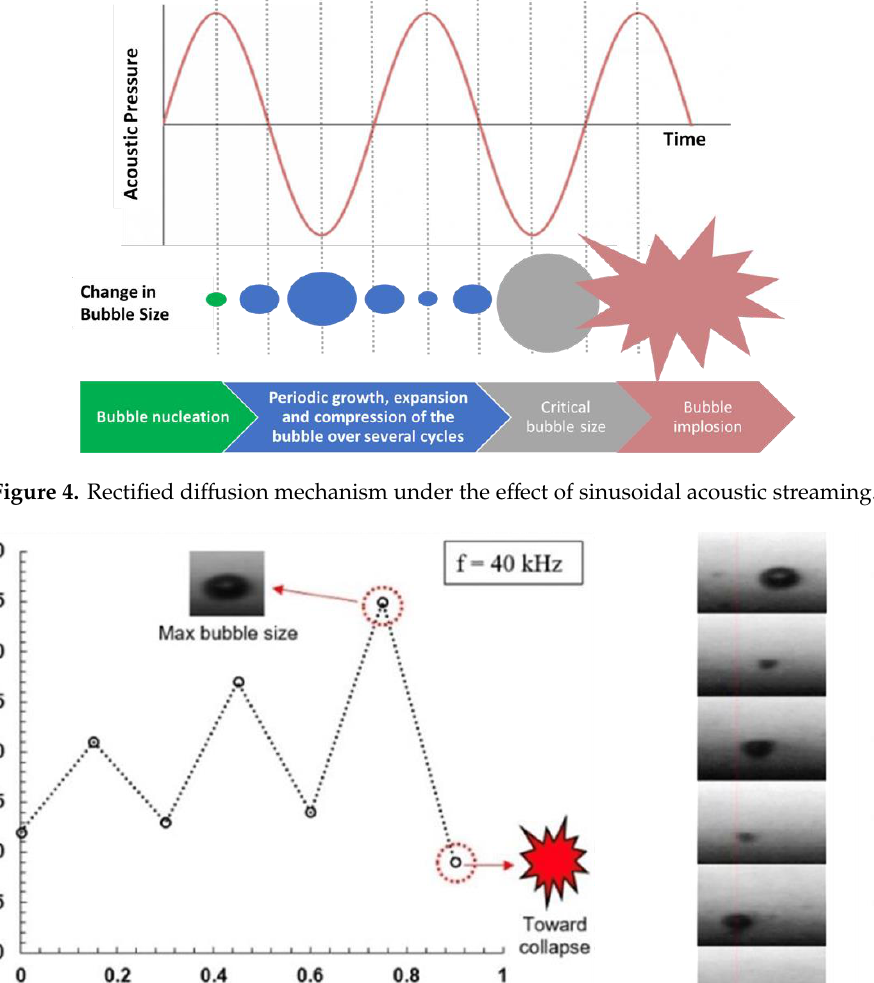
Energies 2020 , 13 , x FOR PEER REVIEW 7 of 15